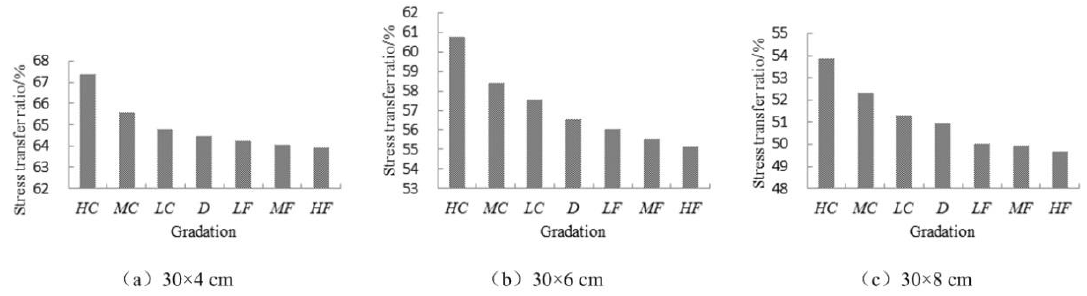
Figure 10. VSTP of asphalt mixtures at different segregation levels.